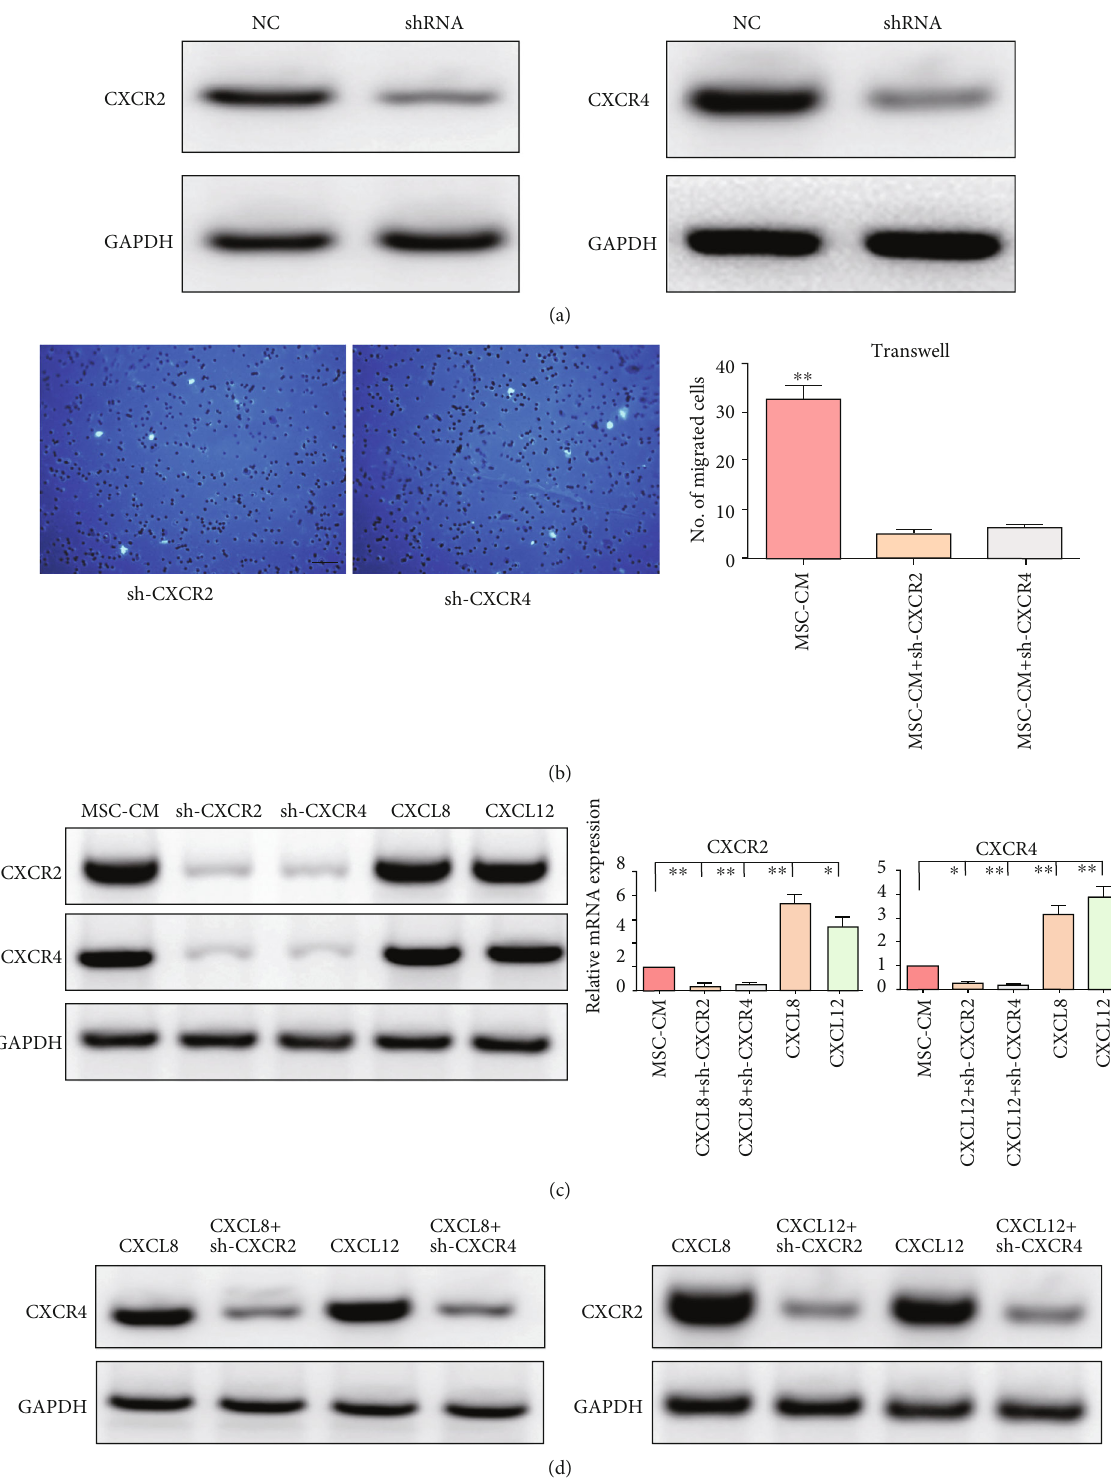
Figure 2: CXCR2 and CXCR4 cross-activated each other. (a) The e ff ectiveness of shRNAs. Gene knockdown was veri fi ed by western blot. (b) Representative images of migrated EPCs. (c) Changes of protein and mRNA expressions after di ff erent treatments. ∗ in red: chemokines vs. MSC-CM; ∗ in blue: shRNA vs. MSC-CM. (d) Changes of protein expressions after di ff erent treatments. NC: negative control; MSC-CM: conditioned media of mesenchymal stem cells. Scale bar, 50 μ m. n = 3 . ∗ p < 0 : 05 and ∗∗ p < 0 : 01